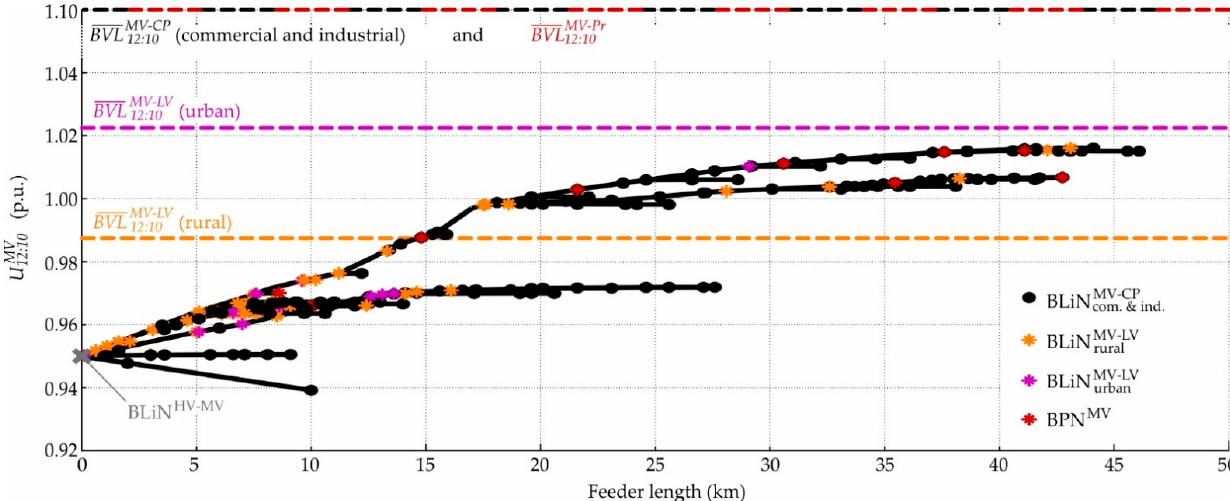
Figure 11. MV feeders’ voltage profiles in case II.